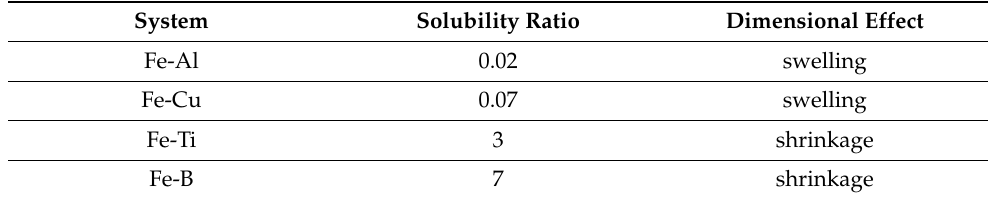
Table 1. Solubility effect on the dimensional behaviour during sintering of ferrous systems